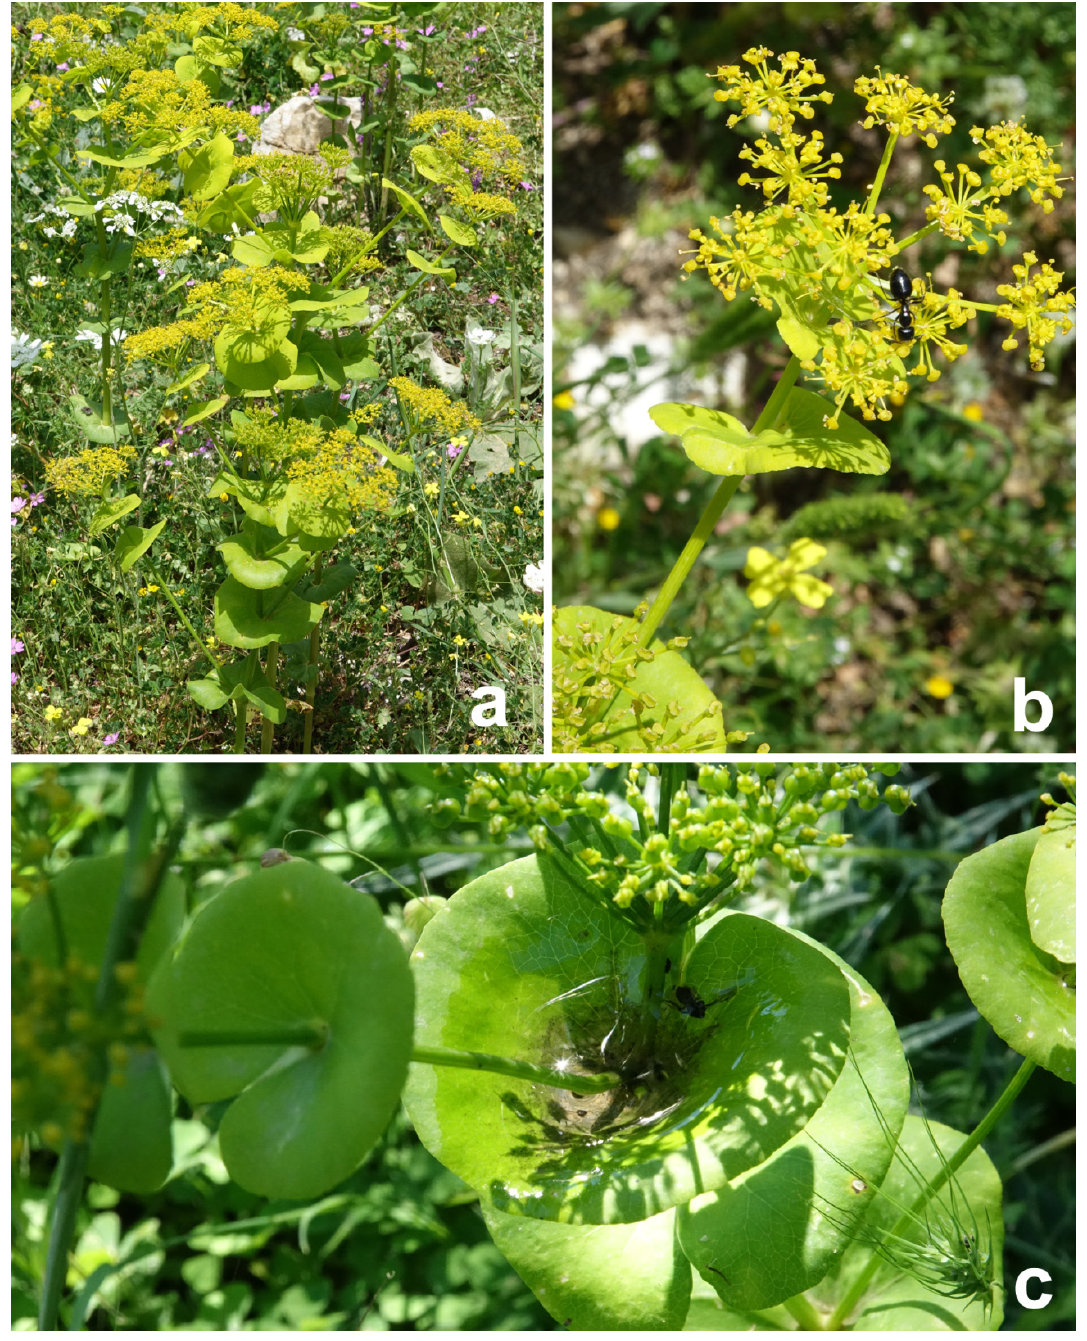
Figure 1. The plant Smyrnium rotundifolium . ( a ) General view of the plant in the natural habitat. ( b ) Branched umbel with an ant foraging on flowers. ( c ) Upper leaves forming a kind of cuff around flower stems. Note a water pool visible in the cuff located in the center of the picture.